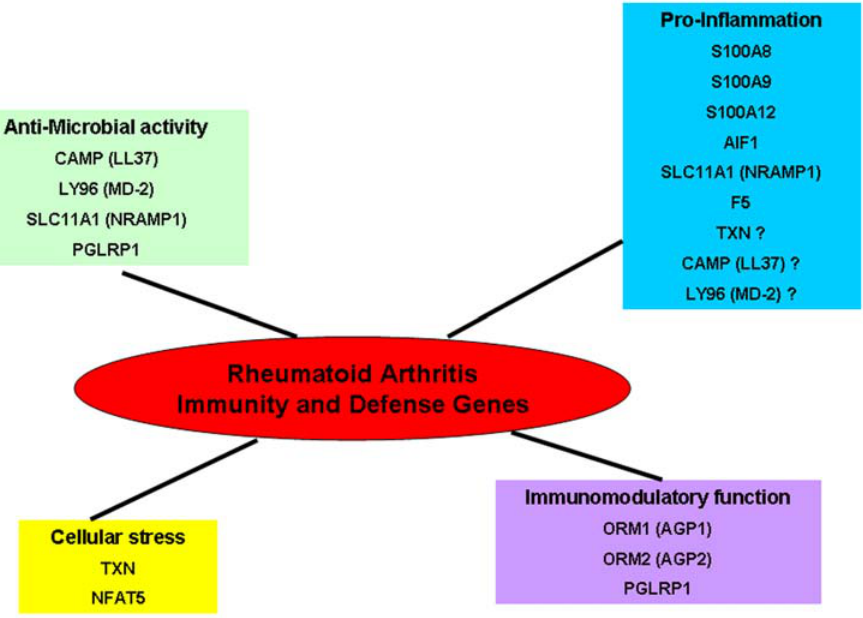
Figure 5. Biological functions of Immunity and Defense genes highlighted in our Rheumatoid Arthritis study. The genes differentially expressed in Immunity and Defense process are stratified in four functional related mechanisms: pro-inflammation, anti-microbial activity, oxidative and osmotic cellular stress and immunomodulatory functions.